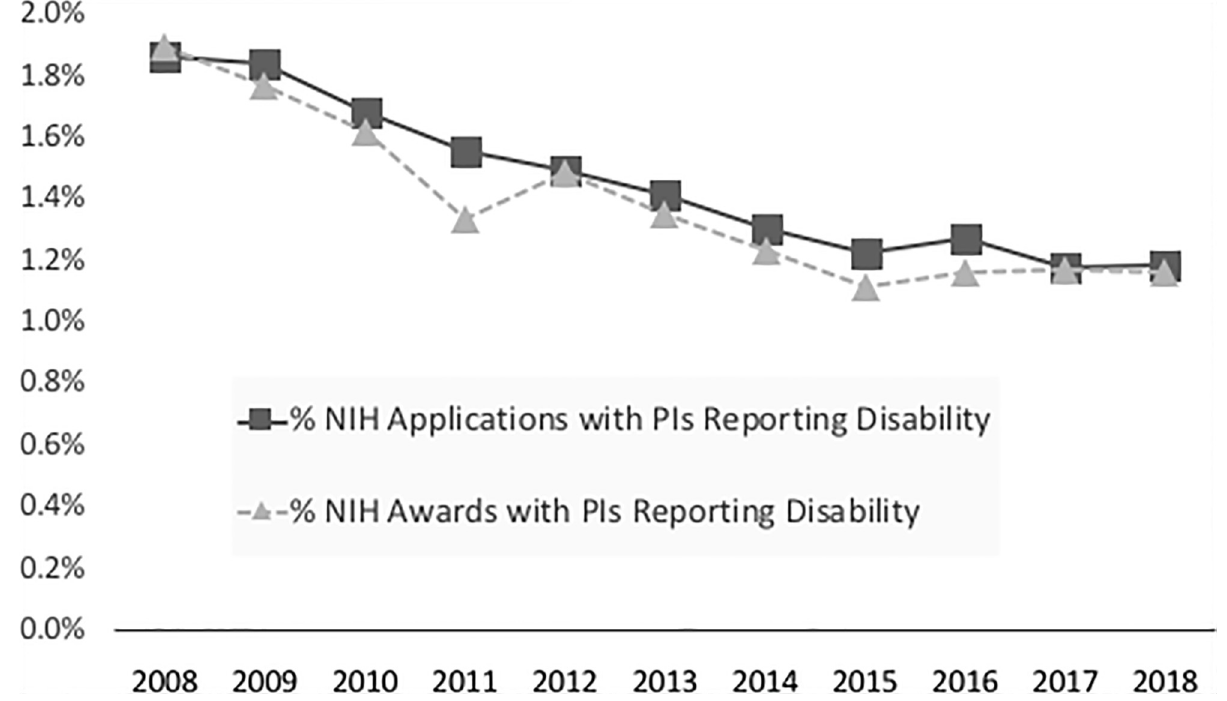
Fig 1. Percentage of National Institute of Health Grant Applications and Awards from Principal Investigators Reporting Disability.